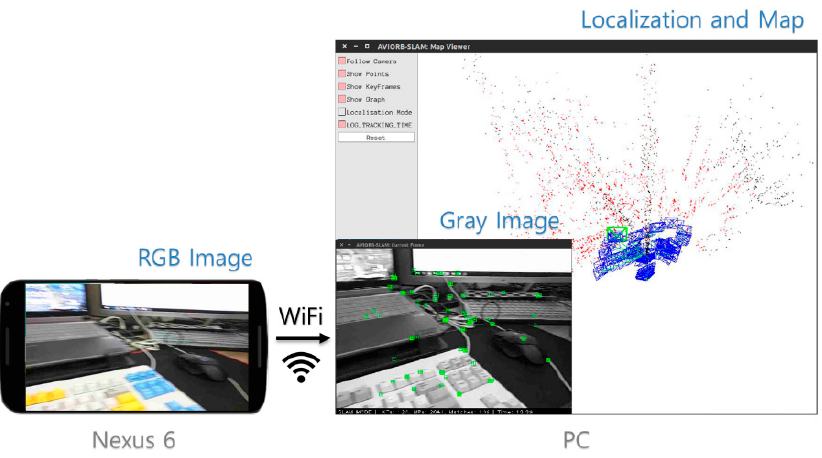
Figure 16. Screenshot of the proposed AVIO-based SLAM with real mobile device sensor data in a PC environment.